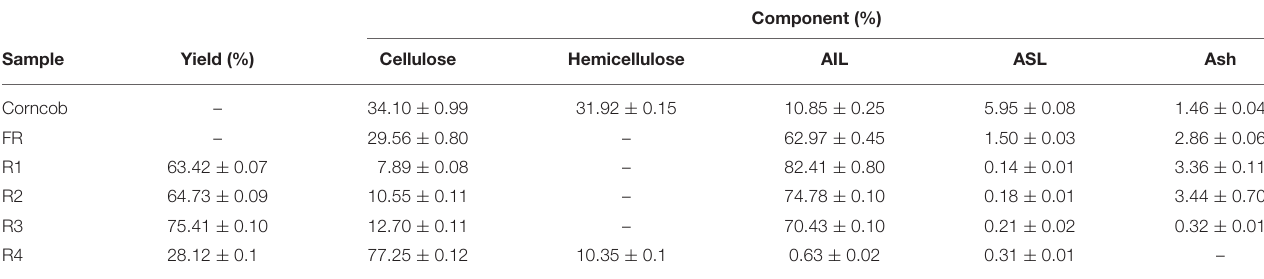
TABLE 6 | Chemical composition of the corncob, original and alkali treated furfural